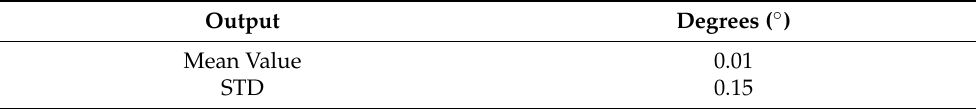
Figure 9. Heading values in controlled rotation from 0 to 360 degrees in four steps. Table 3. Differences between the nominal and measured angles experienced in tests involving complete overturns.